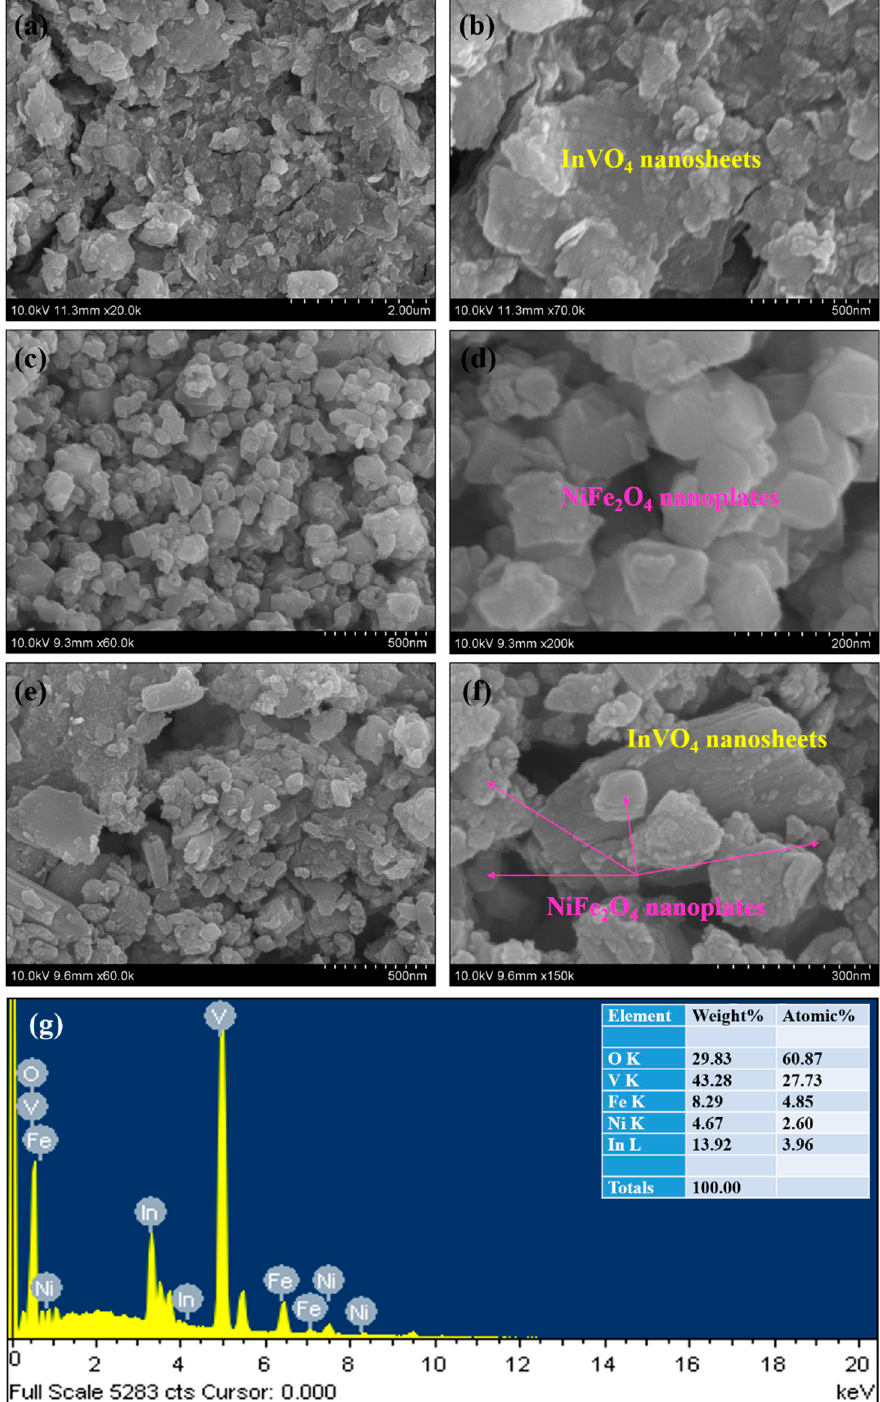
Figure 2. Scanning electron microscopy images of ( a , b ) InVO 4 nanosheets, ( c , d ) NiFe 2 O 4 nanoplates, ( e , f ) IVNF-5.0 nanocomposite, and ( g ) energy-dispersive spectroscopy (EDS) analysis of the IVNF-5.0 nanocomposite .